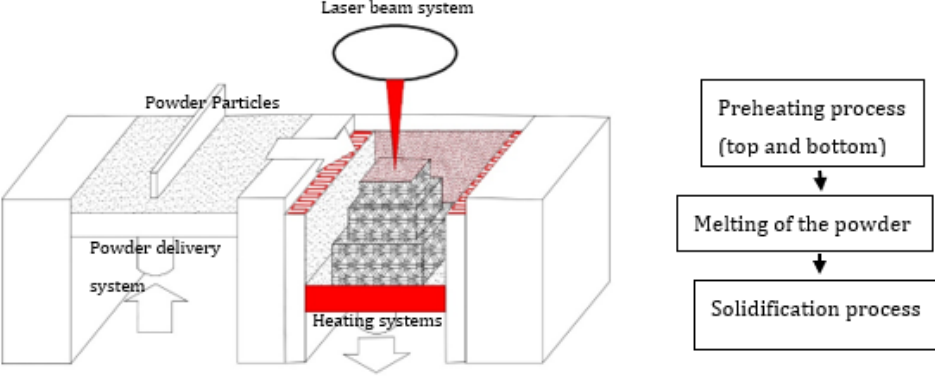
Figure 6. Schematic representation of the LPBF manufacturing system—preheating process (top and bottom).